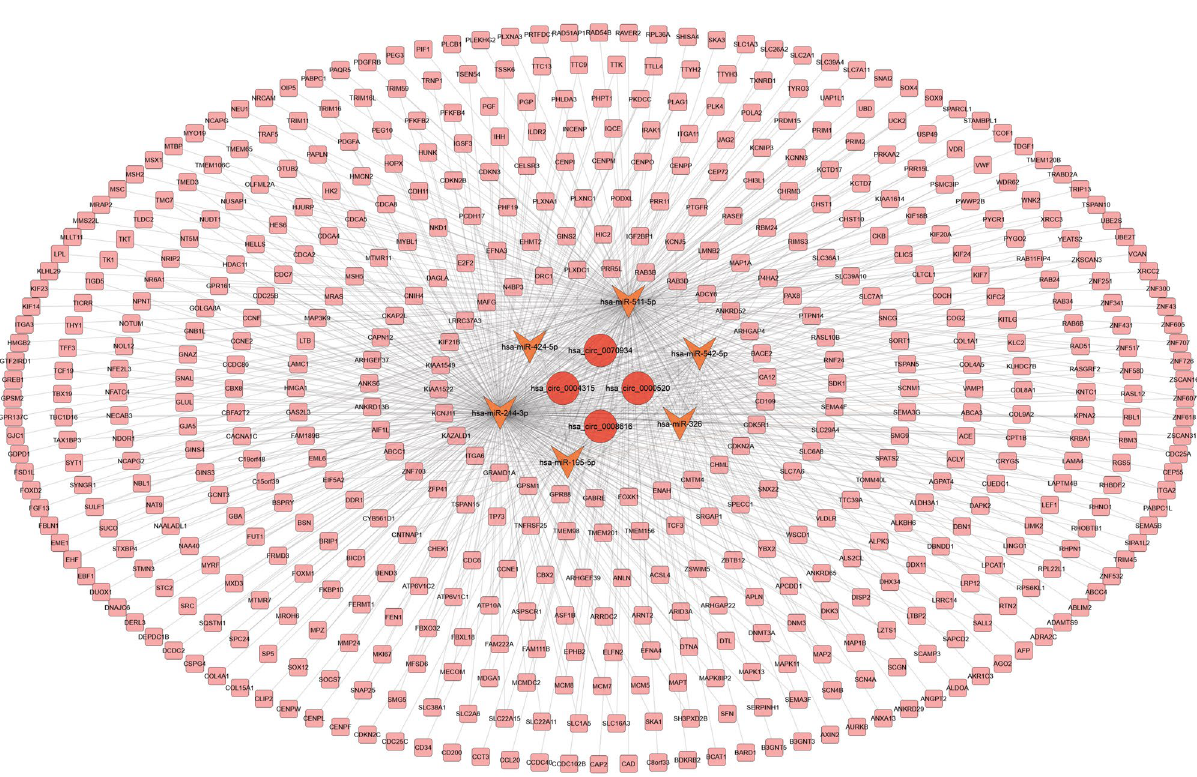
Figure 5. ceRNA network. The network consisting of four DECs (hsa_circ_0000520, hsa_circ_0008616, hsa_ circ_0070934, hsa_circ_0004315) and six FImiRNAs (hsa-miR-542-5p, has-miR-326, has-miR-511-5p, has-miR- 195-5p, has-miR-214-3p, has-miR-424-5p) and 543 FImRNAs. Ellipse represents circRNA, V represents miRNA and Round Rectangle represents